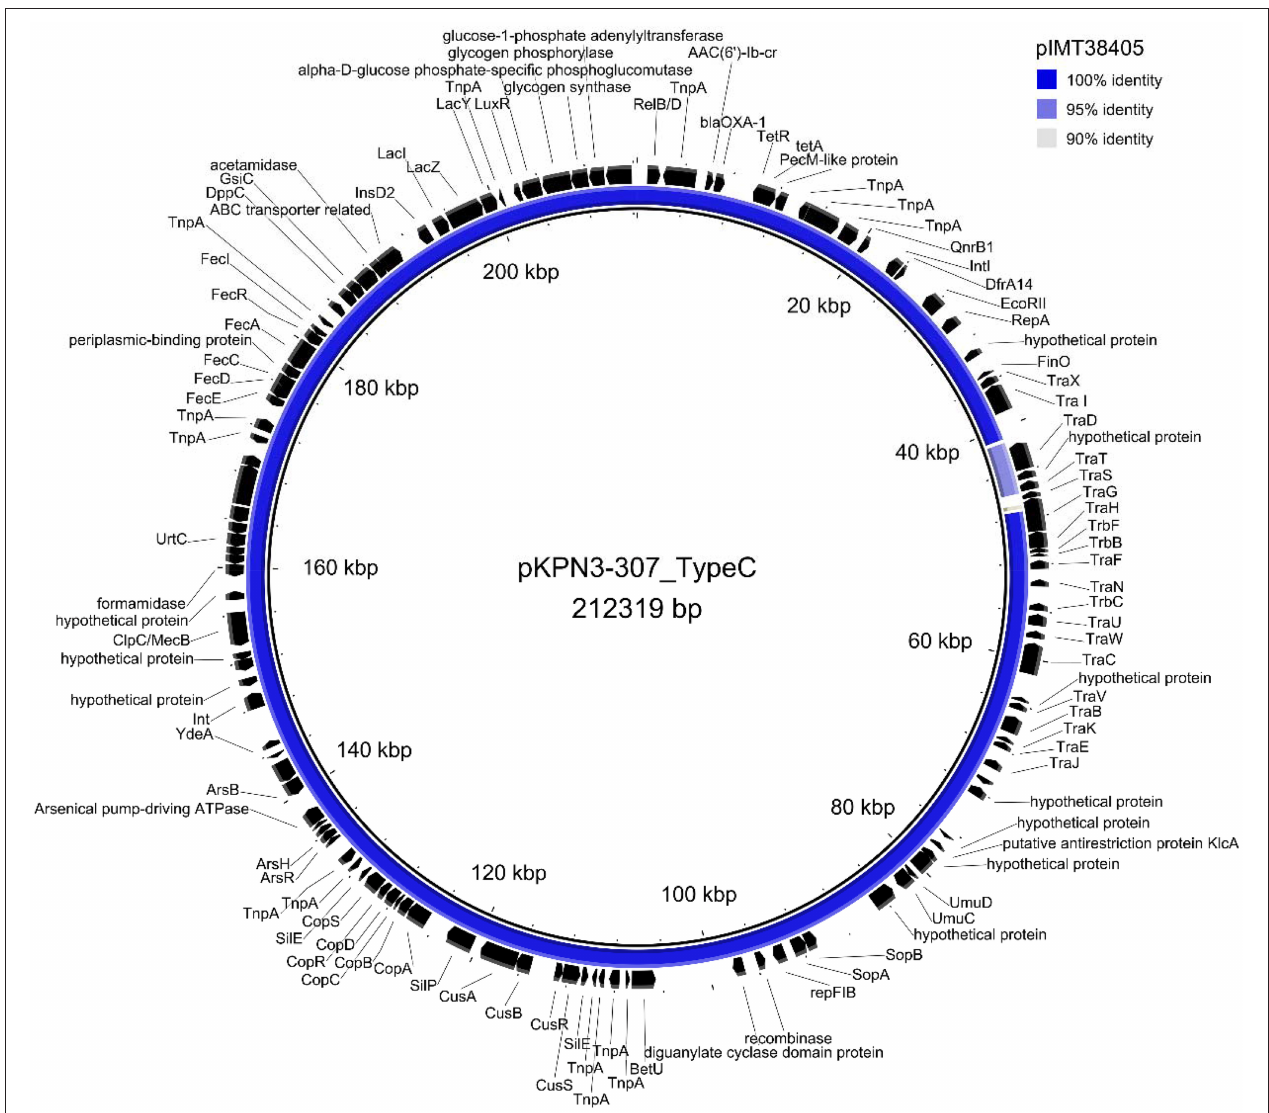
FIGURE 2 | Circular visualization of plasmid pIMT38405 of K. pneumoniae ST307 resulting from a mapping of Illumina reads against plasmid pKPN3-307_TypeC (Villa et al., 2017) as a reference sequence using Blast Ring Image Generator (BRIG) (Alikhan et al., 2011).